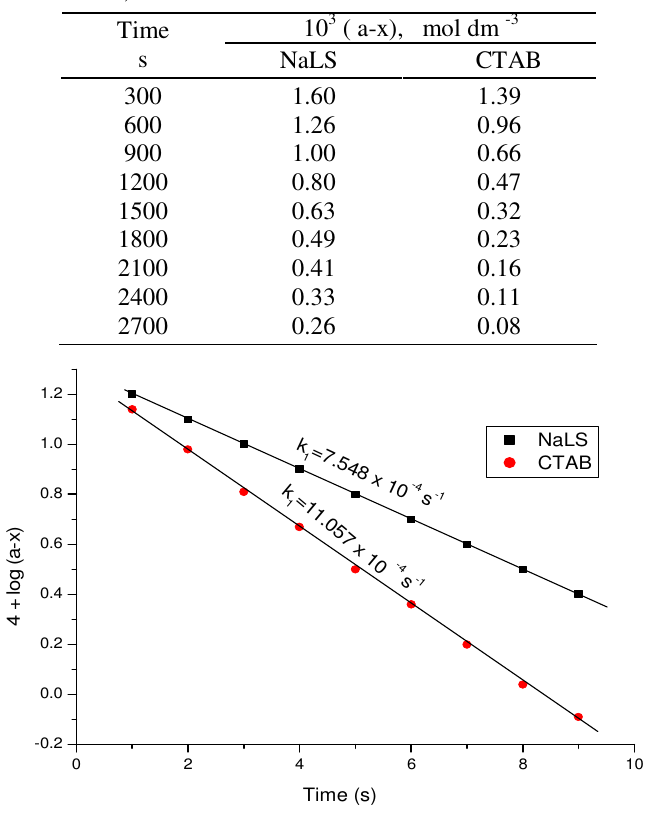
Figure 1. First order dependence